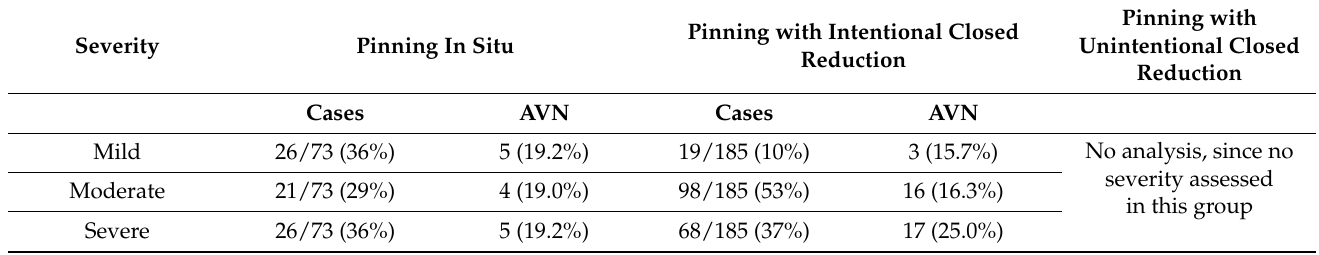
Table 4. Rates of AVN according to severity and method of intervention in closed pinning.